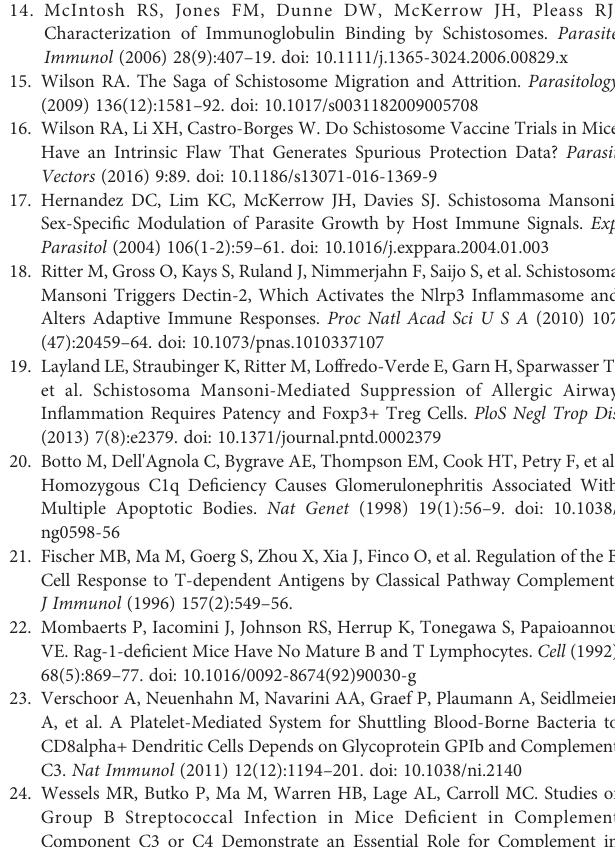
Supplementary Figure 1 | Morphological effect of Rag1 -/- serum on NTS. NTS were cultured in HM in the presence or absence of 20% WT or Rag1 -/- serum. Microphotographs were taken at indicated time points with a digital camera fi tted to an inverted microscope (10x). Supplementary Figure 2 | Loss of C1q does not alter cytokine production by splenocytes. Lymphocytes (2x10 5 ) from wild-type or C1q -/- mice infected for 11 weeks with S. mansoni were re-stimulated in vitro with or without (Ctrl) SEA (20 µg/ ml) or anti-CD3/28 (1µg/ml) for 48 h. Secreted levels of IFN- g (A) or IL-10 (B) were analyzed in the culture supernatants by ELISA. Graph shows representative data from at least 3 independent infection experiments. Each data point has been shown as mean ± SD of at least three technical replicates. (*P <0.05, **P <0.01). Inf, infected. Supplementary Table 1 | Viability scoring points